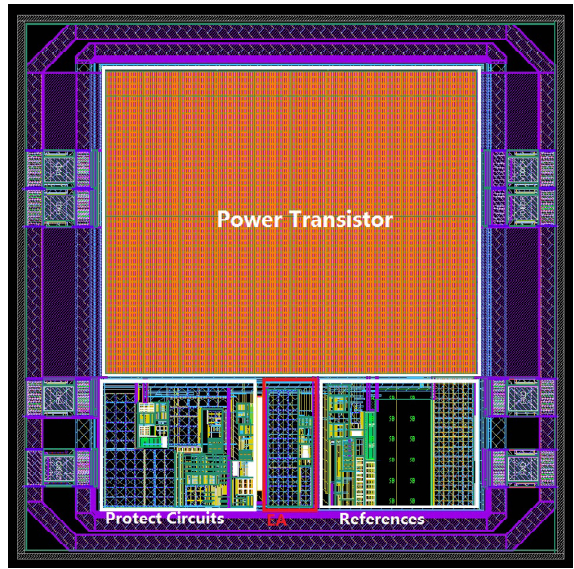
Figure 8. Layout of the proposed LDO.